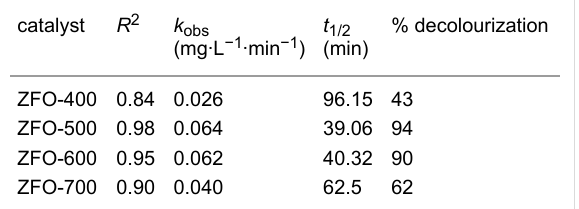
Table 2: Zero-order fitting parameters of Rh B decolourization over ZFO